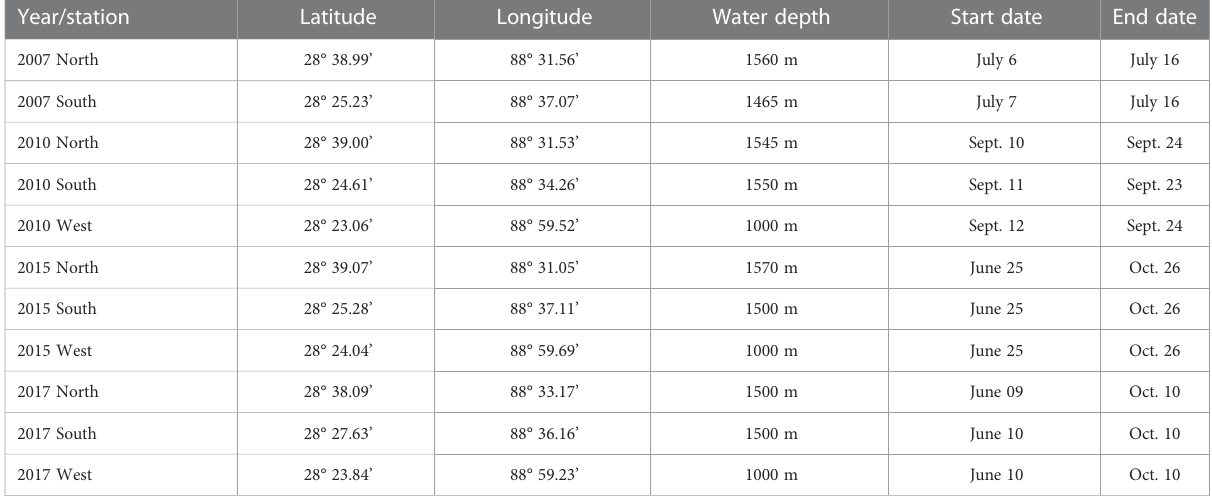
TABLE 1 Geographic locations of EARS buoy moorings and the start/deployment and end/retrieval